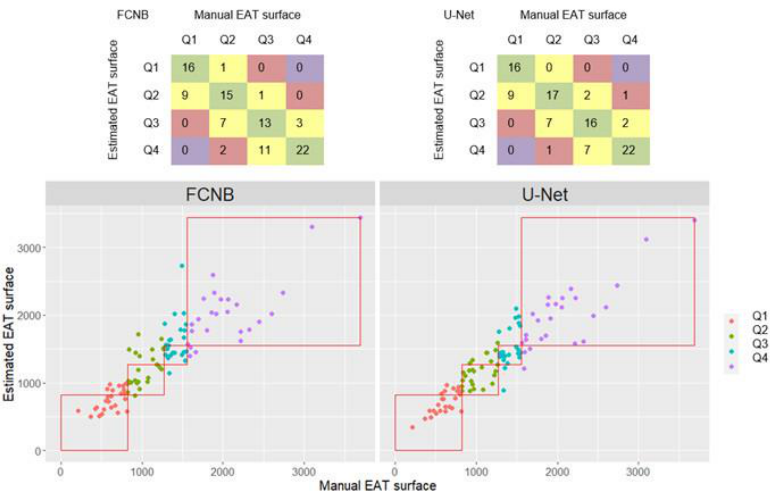
Figure 5. Quartile classification results from EAT area estimated from networks segmentation against classification from manual EAT area. Only segmentations from preferred systolic frames were shown here. Markers colors were defined by manual EAT quartiles. Red squares delineate manual EAT quartiles.